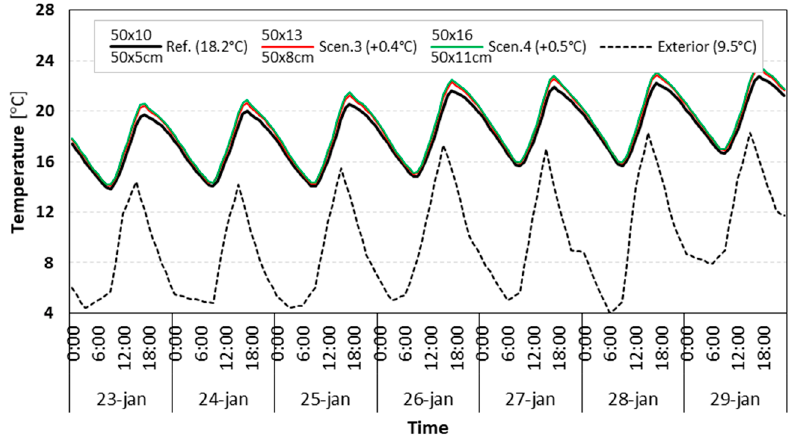
Figure 14. Influence of different dimensions of the air vents.